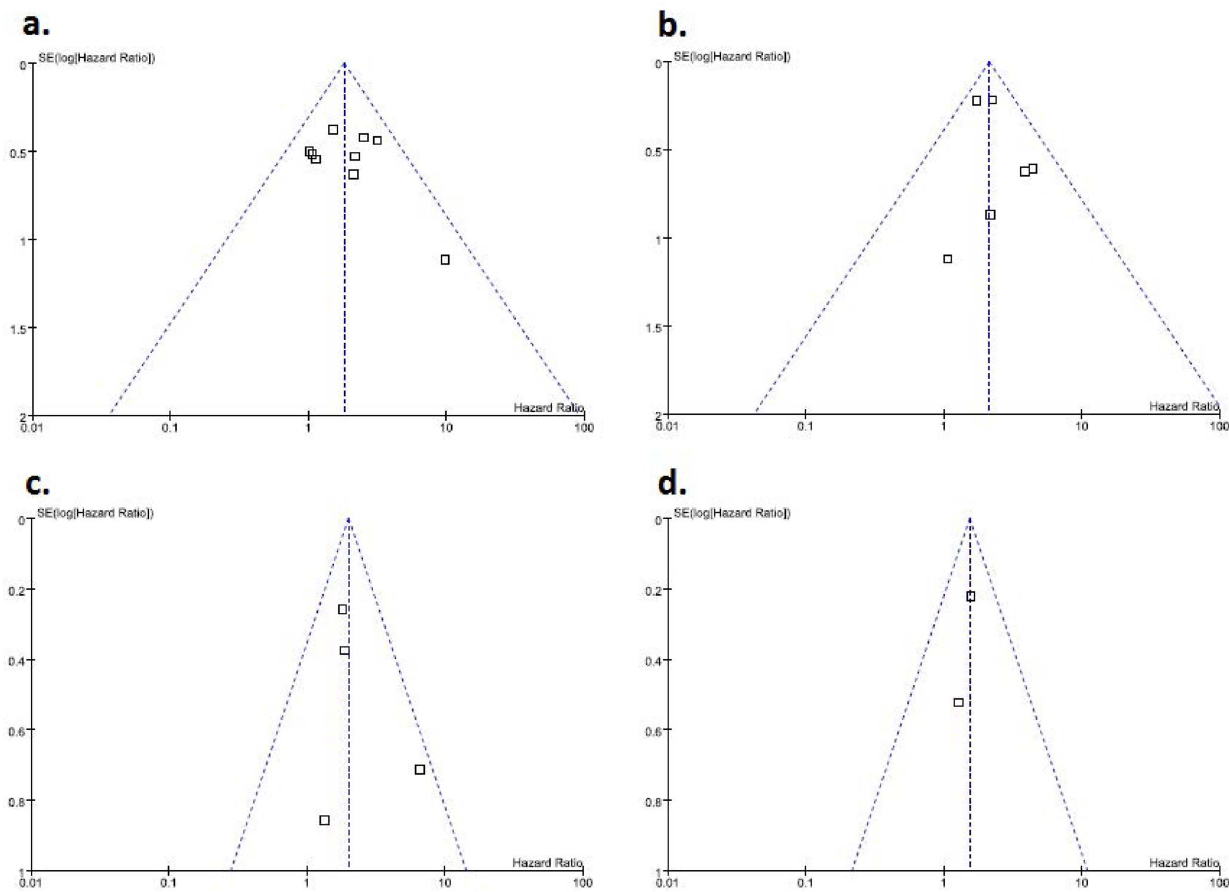
Figure 3. Funnel graphs of the assessment of potential publication bias in studies of survivin expression in patients with non- muscle invasive bladder tumor. (A) Recurrence-free survival. (B) Progression-free survival. (C) Cancer-specific survival. (D) Overall survival.